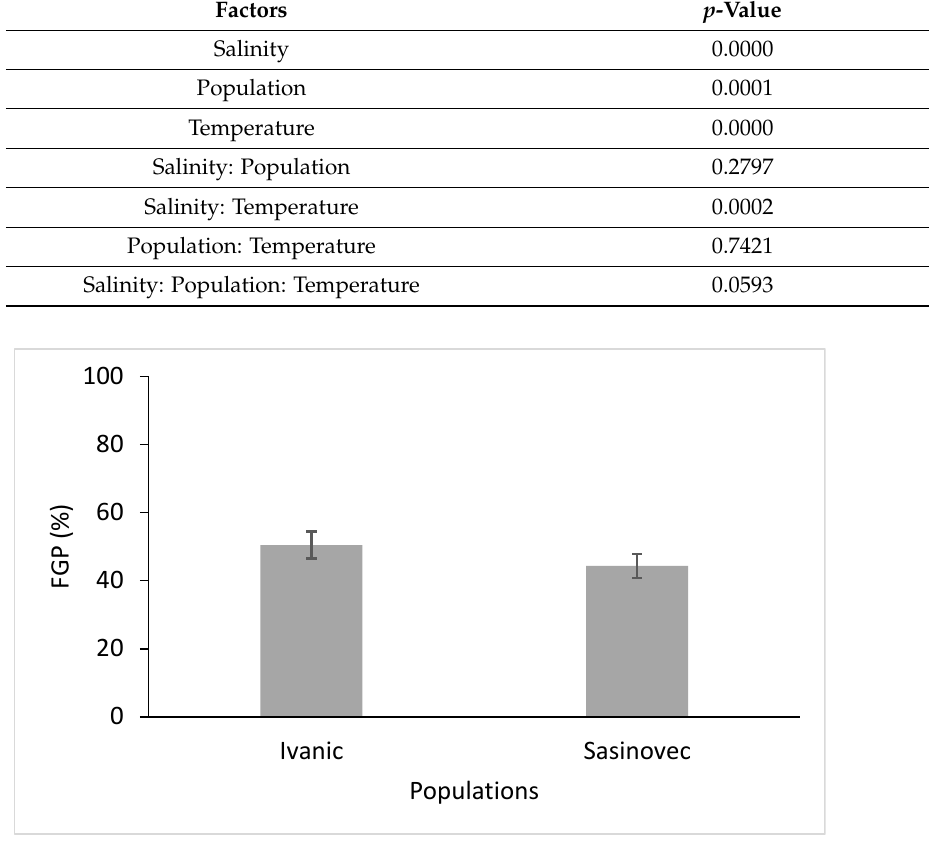
Figure 2. Final germination percentages (FGP) of the two populations of D. stramonium (data from the different temperature ranges and salinity levels were averaged). Vertical bars represent the standard errors.